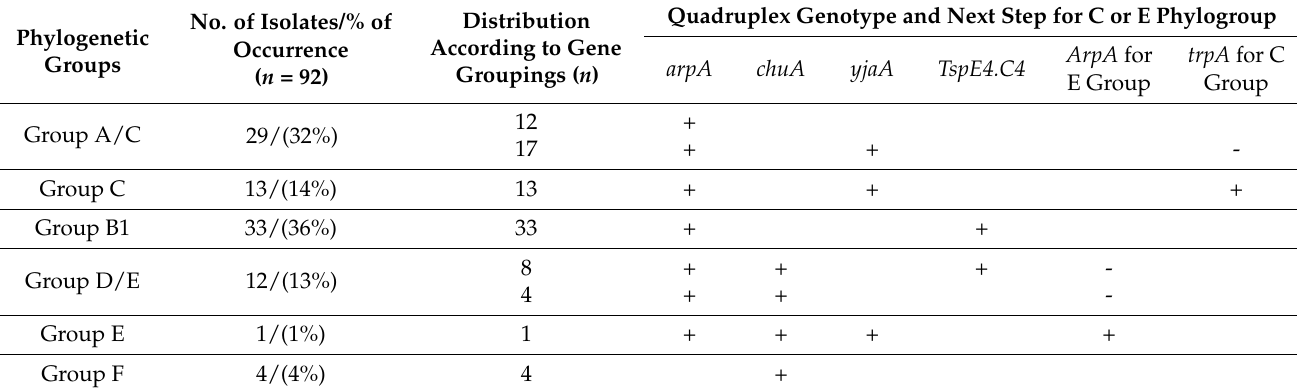
Table 2. Phylogenetic distribution of E. coli from unpasteurized